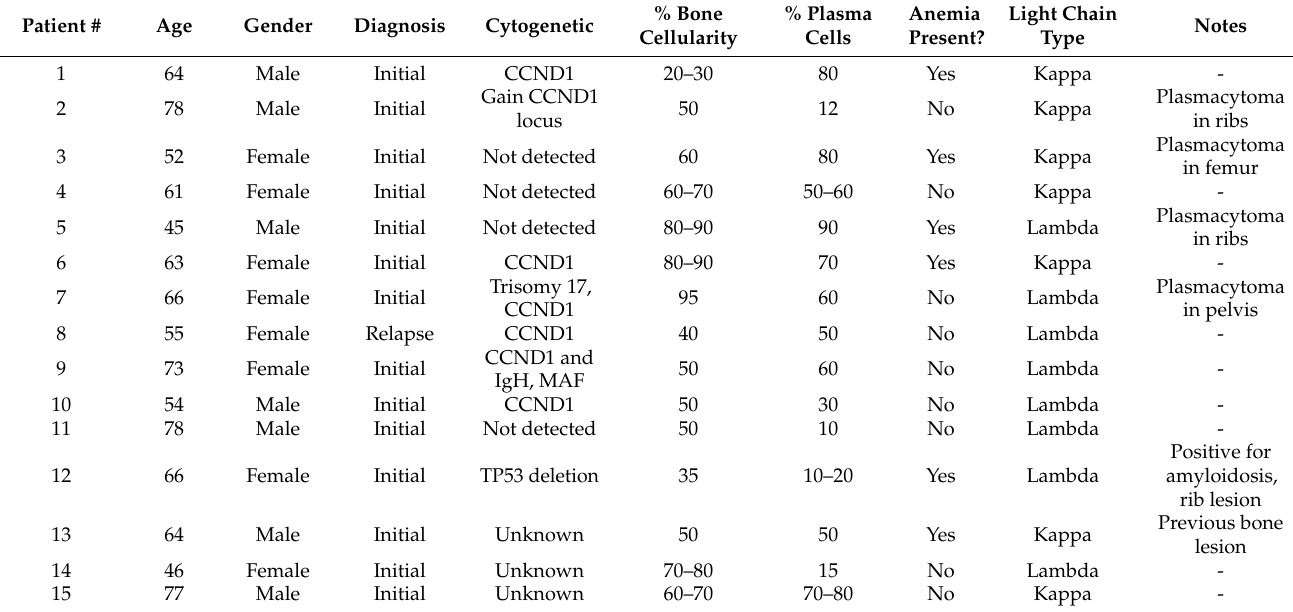
Table 1. Characteristics of patients whose bone marrow cells were used in this